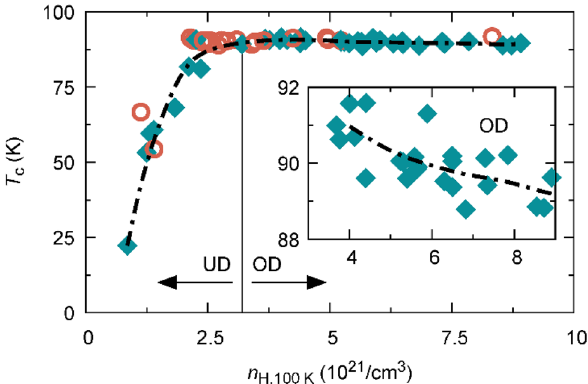
Figure 2. Phase diagram of YBCO thin films. Zero field critical temperature as a function of charge carrier density, n H , obtained by Hall effect measurements at 100 K for thin YBCO films grown by PLD (200 nm thick, cyan diamonds) and CSD (250 nm thick, red circles). Vertical line marks optimally doping, while arrows indicate underdoped (UD) and overdoped (OD) regime. Inset magnifies T c in the overdoped regime, showing a weak but distinct decrease with increasing charge carrier density, from above 91 K to around 89